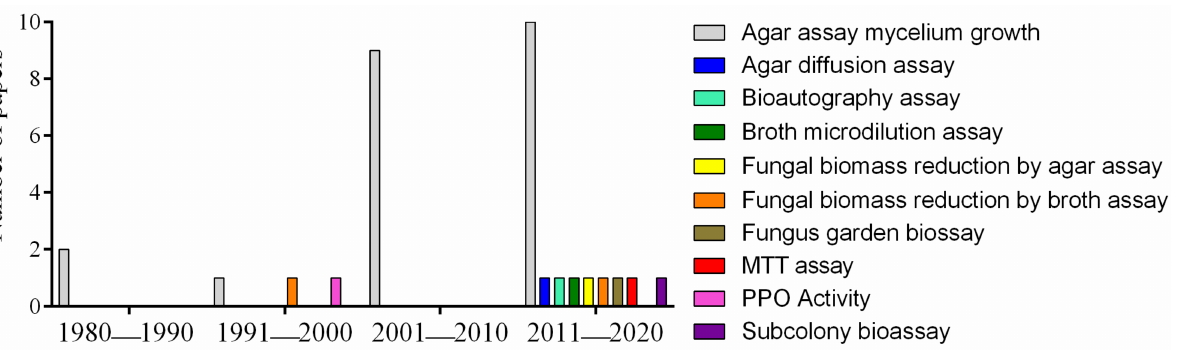
Figure 5. Different types of antifungal methodologies performed on Leucoagaricus gongylophorus according to each